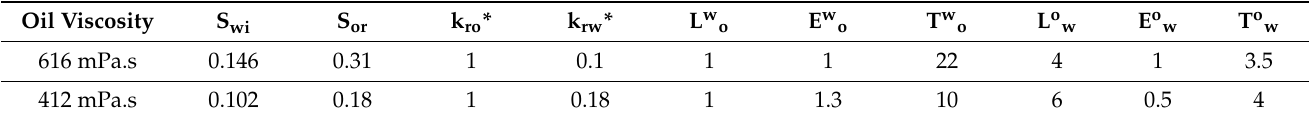
Table 5. LET input parameters for the 412 mPa.s and 616 mPa.s oil displacement case. Oil Viscosity